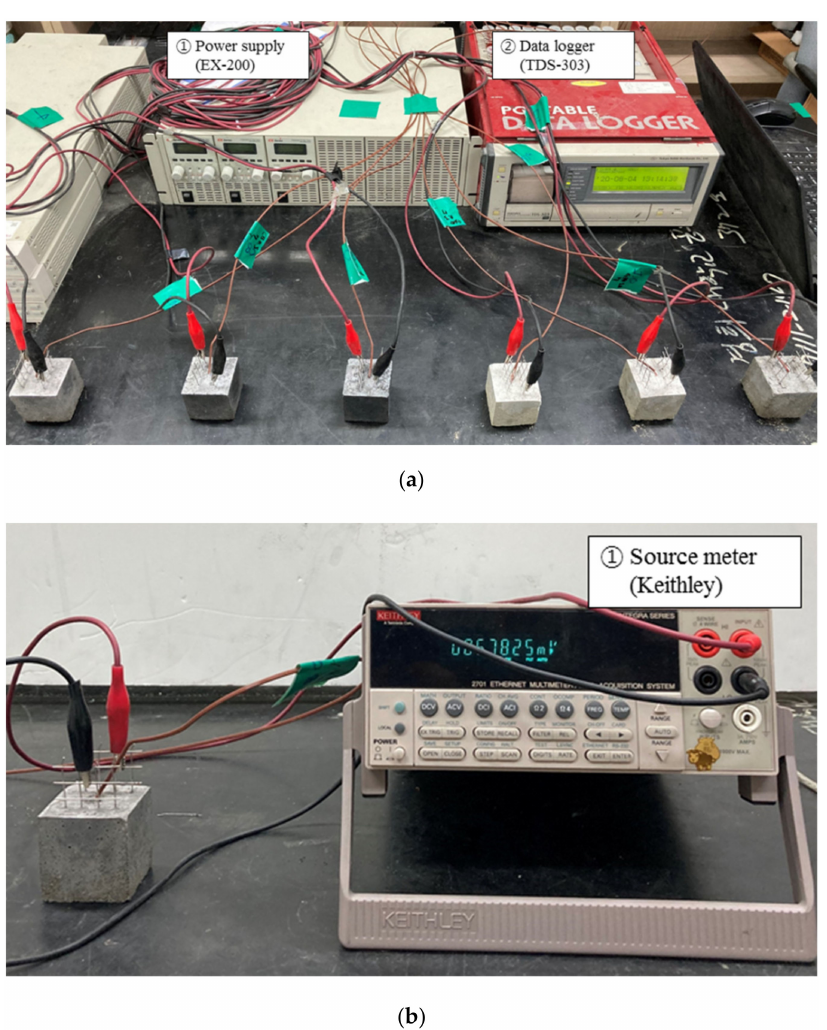
Figure 3. Test setup: ( a ) Heating performance test, ( b ) Resistance